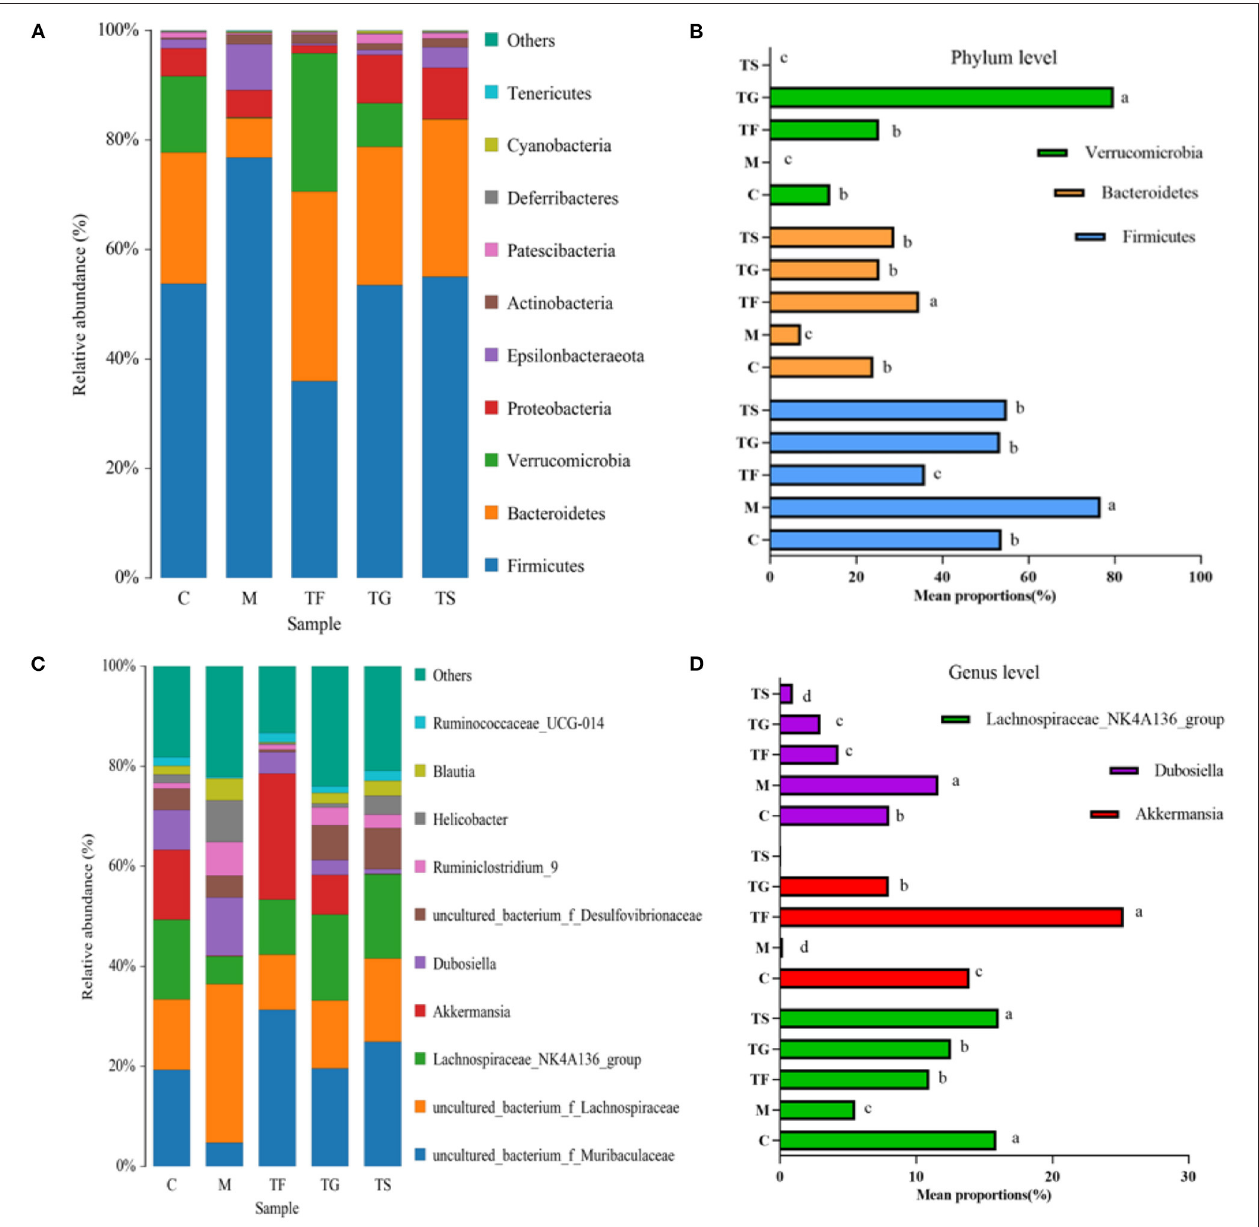
FIGURE 6 | Effects of GABA-rich sprouted adzuki beans on the microbial composition of the caecum in mice with T2DM. (A) Relative abundances of microbial taxa at the phylum level. (B) Comparative analysis of the top three phyla with the highest relative abundances. (C) Relative abundances of microbial taxa at the genus level. (D) Comparative analysis of the top three genera (excluding non-annotated OTUs at the genus level) with the highest relative abundances. The values with different symbols indicate that they differ substantially ( p < 0.05) from each other.